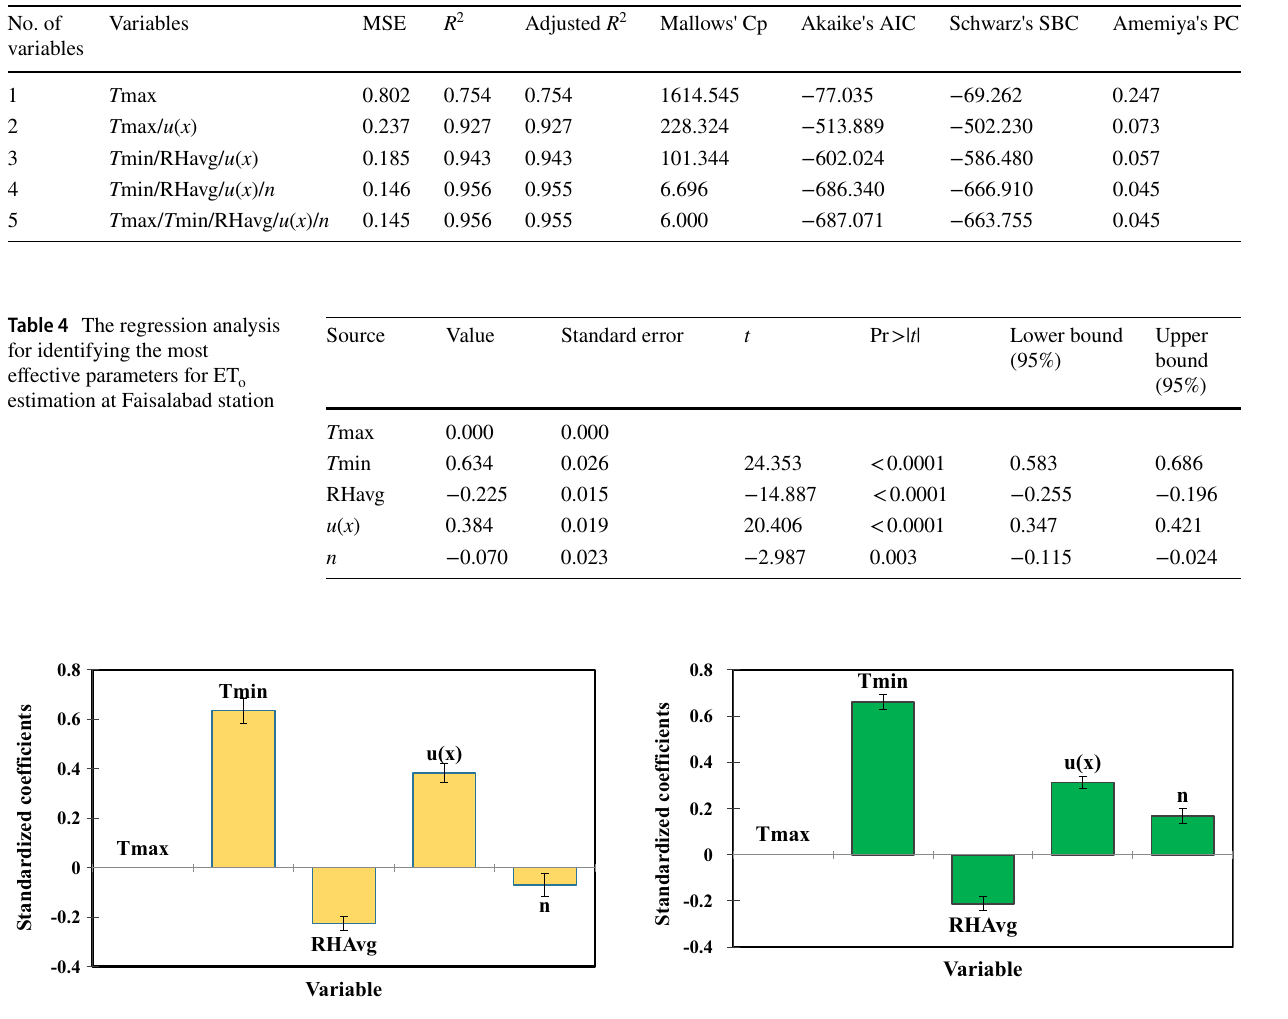
Fig. 3 The standardized coefficients of input variable for sensitivity analysis at Islamabad station for reference